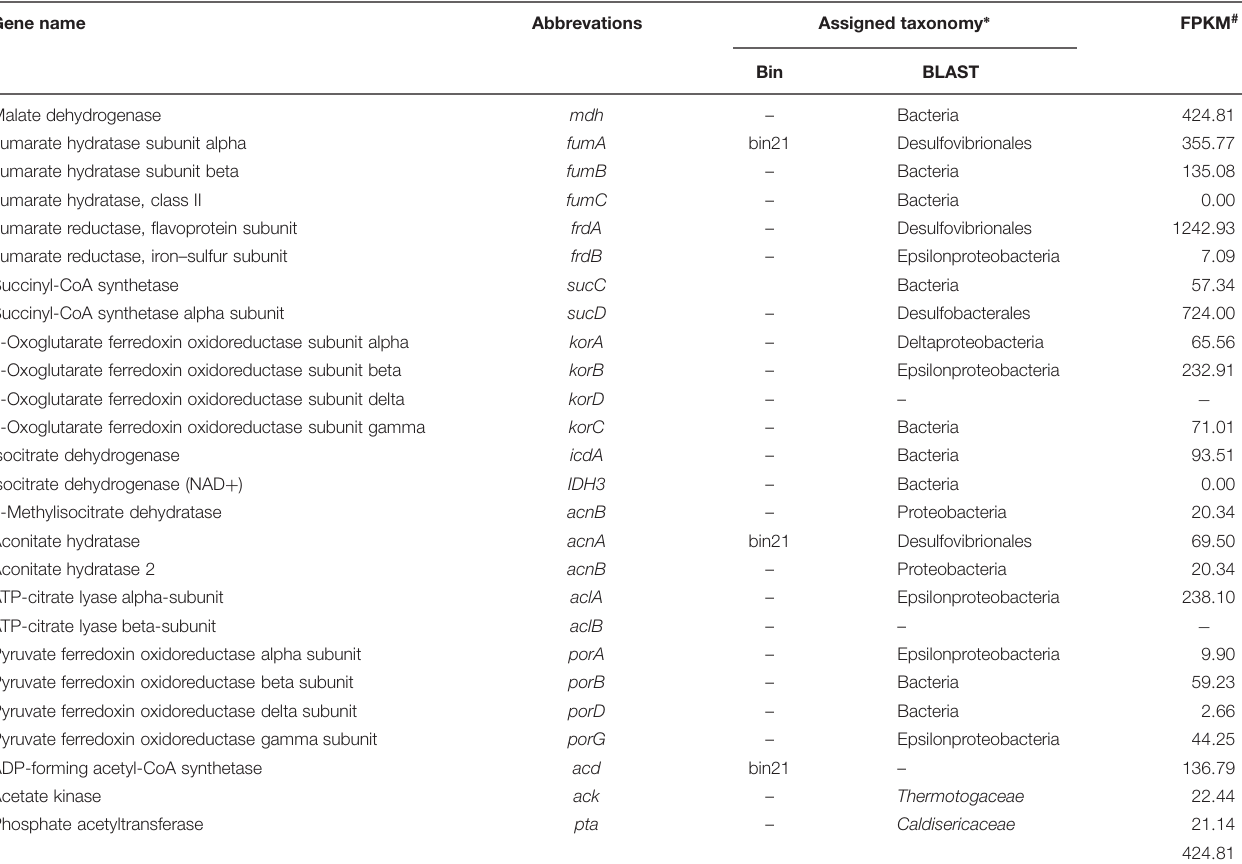
TABLE 3 | Genes identified in the rTCA pathway in Delta- and Epsilonproteobacteria